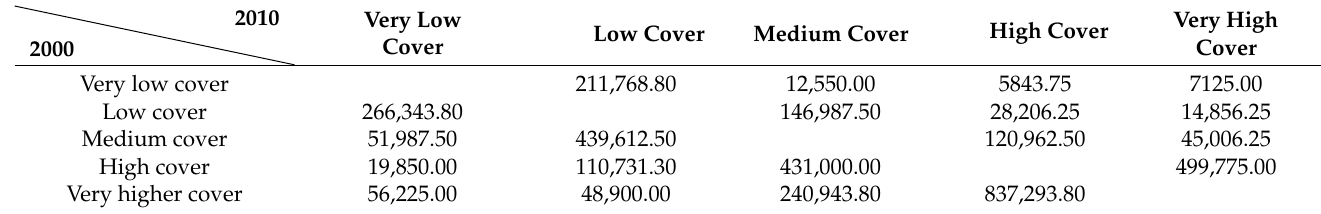
Table 5. FVC transition matrix from 2000 to 2010 (hm 2 ).